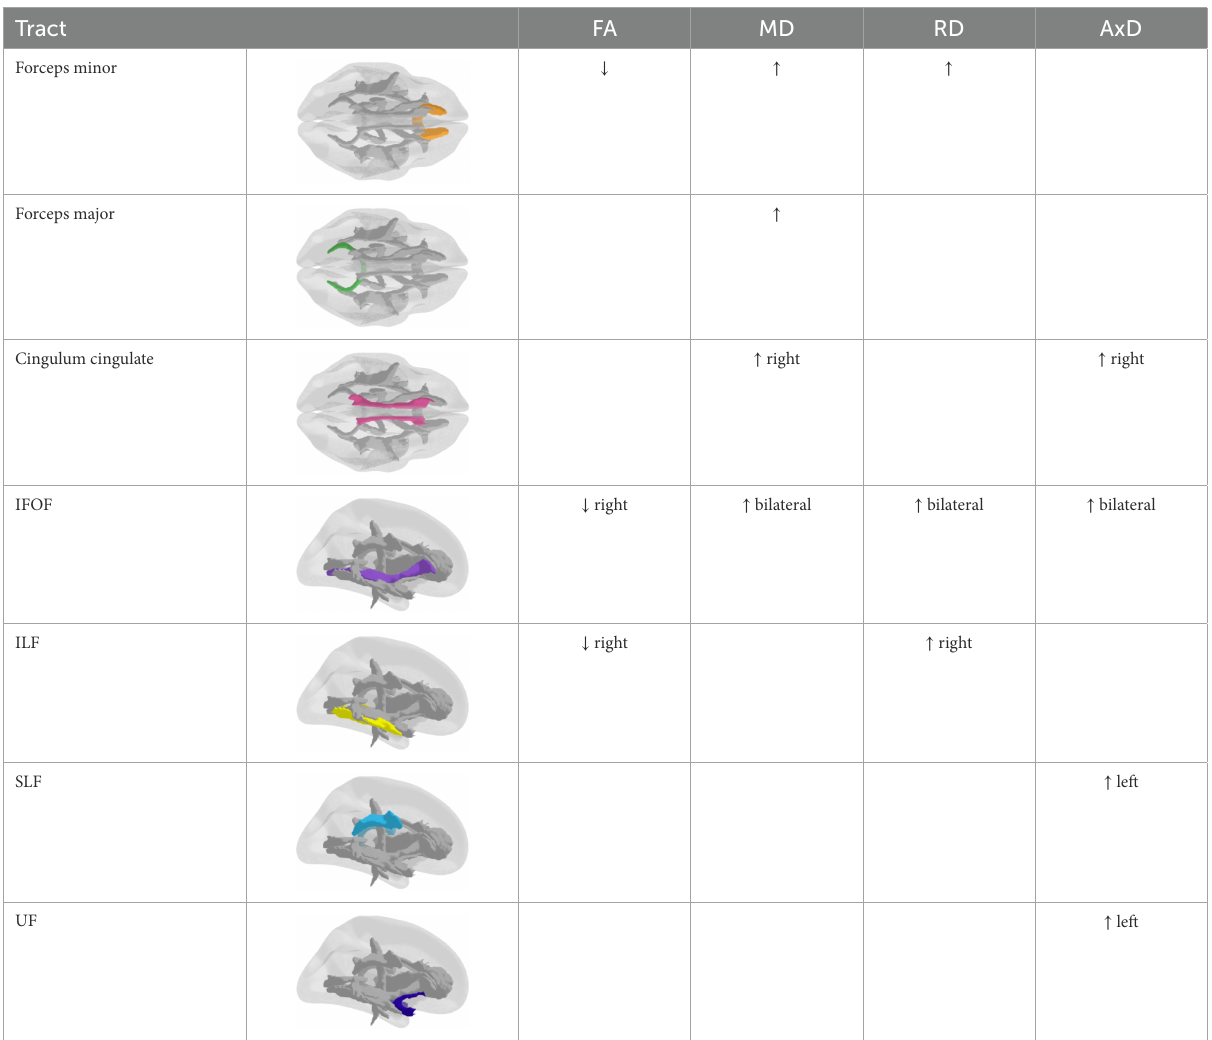
TABLE 2 Summary of DTI findings by